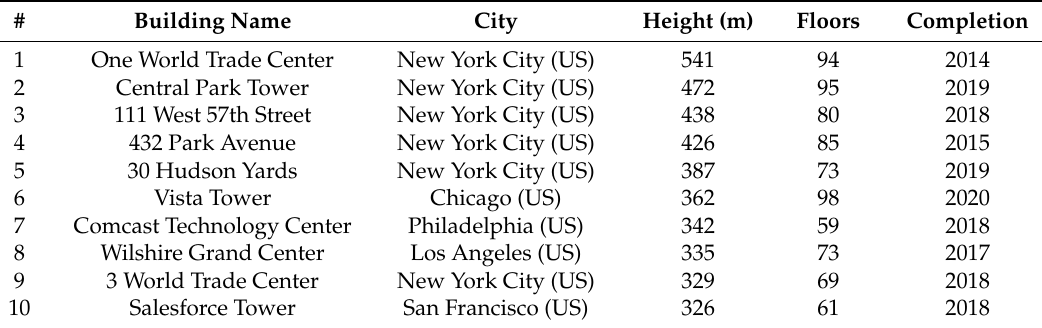
Table 7. North America’s 10 tallest skyscrapers in